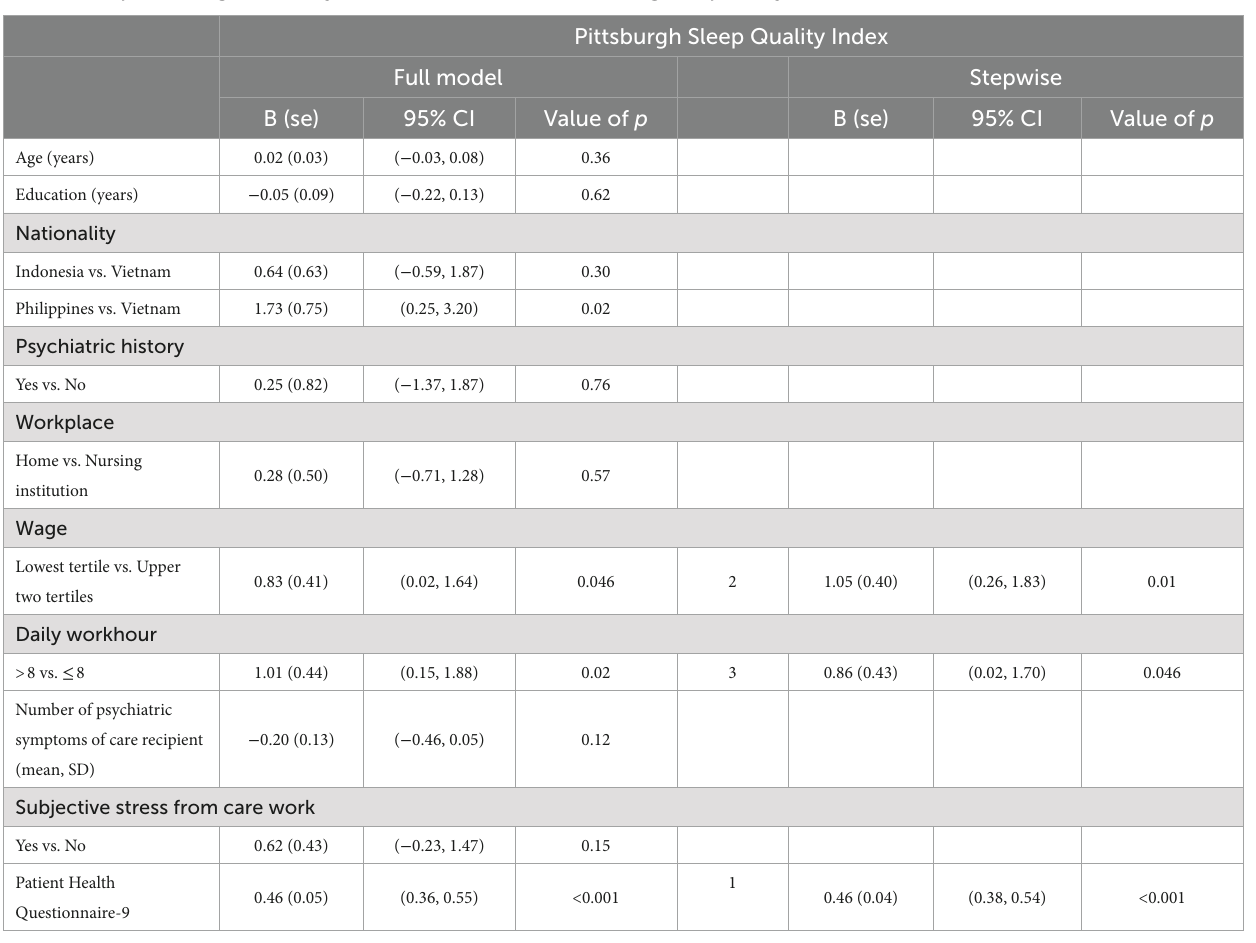
TABLE 4 Multiple linear regression analyses for factors associated with Pittsburgh Sleep Quality